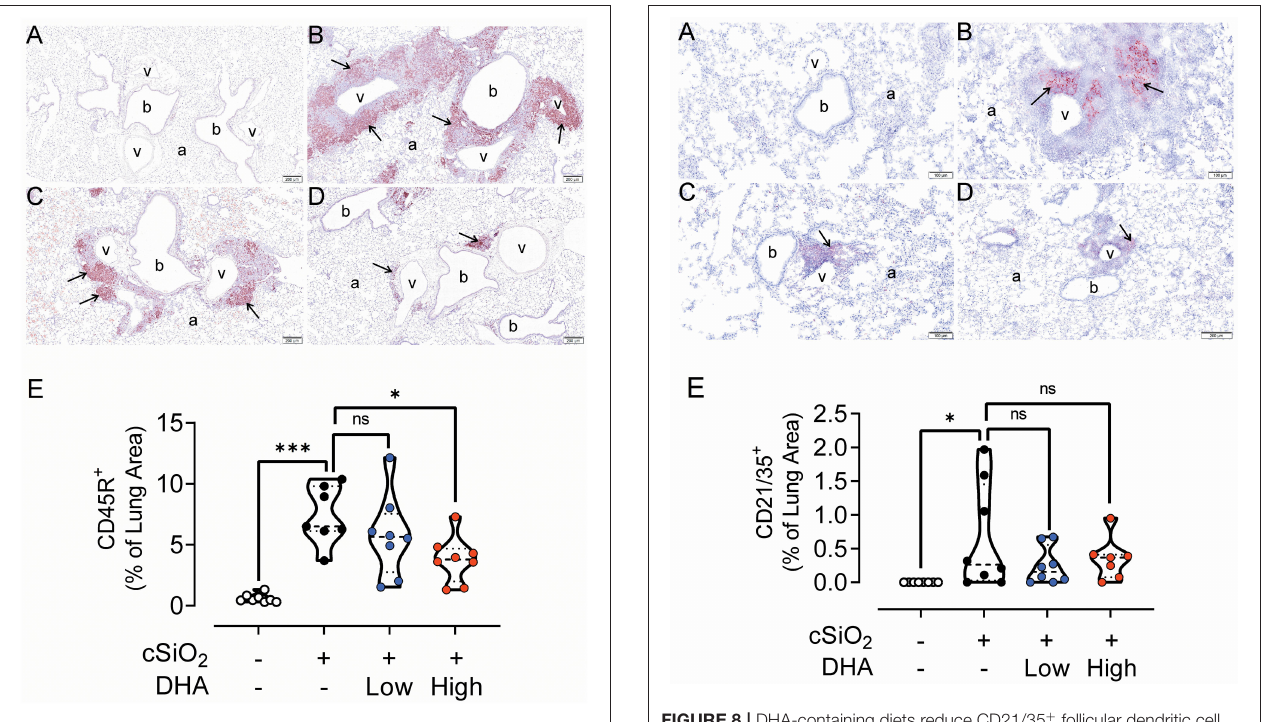
macrophages, lymphocytes, and neutrophils in the BALF compared to vehicle-treated CON-fed mice ( Figures 4A–D